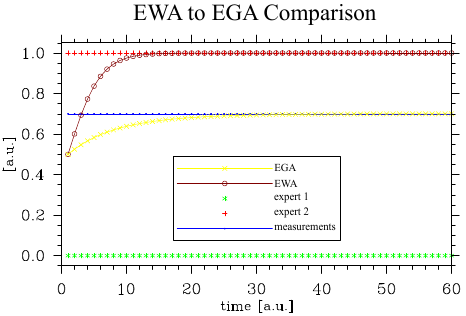
Figure 1. An ideal experiment with two experts. The first always predicts zero and the second always predicts one. The true value is always 0.7. The EWA forecaster converges to the best model (pre- dicting one) while the EGA forecaster converges to the true